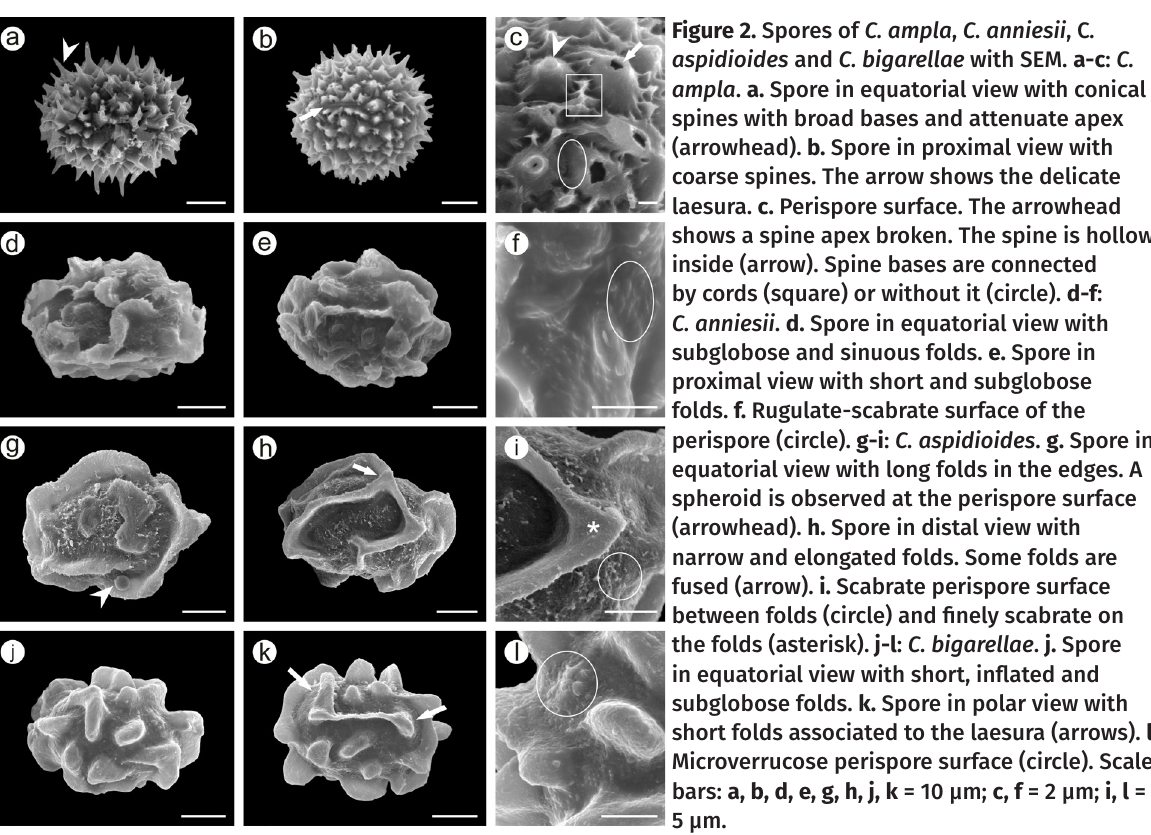
Figure 2. Spores of C. ampla , C. anniesii , C . aspidioides and C. bigarellae with SEM. a-c : C. ampla . a. Spore in equatorial view with conical spines with broad bases and attenuate apex (arrowhead). b. Spore in proximal view with coarse spines. The arrow shows the delicate laesura. c. Perispore surface. The arrowhead shows a spine apex broken. The spine is hollow inside (arrow). Spine bases are connected by cords (square) or without it (circle). d-f : C. anniesii . d. Spore in equatorial view with subglobose and sinuous folds. e. Spore in proximal view with short and subglobose folds. f. Rugulate-scabrate surface of the perispore (circle). g-i : C. aspidioides . g. Spore in equatorial view with long folds in the edges. A spheroid is observed at the perispore surface (arrowhead). h. Spore in distal view with narrow and elongated folds. Some folds are fused (arrow). i. Scabrate perispore surface between folds (circle) and finely scabrate on the folds (asterisk). j-l : C. bigarellae . j. Spore in equatorial view with short, inflated and subglobose folds. k. Spore in polar view with short folds associated to the laesura (arrows). l. Microverrucose perispore surface (circle). Scale bars: a, b, d, e, g, h, j, k = 10 µm; c, f = 2 µm; i, l = 5